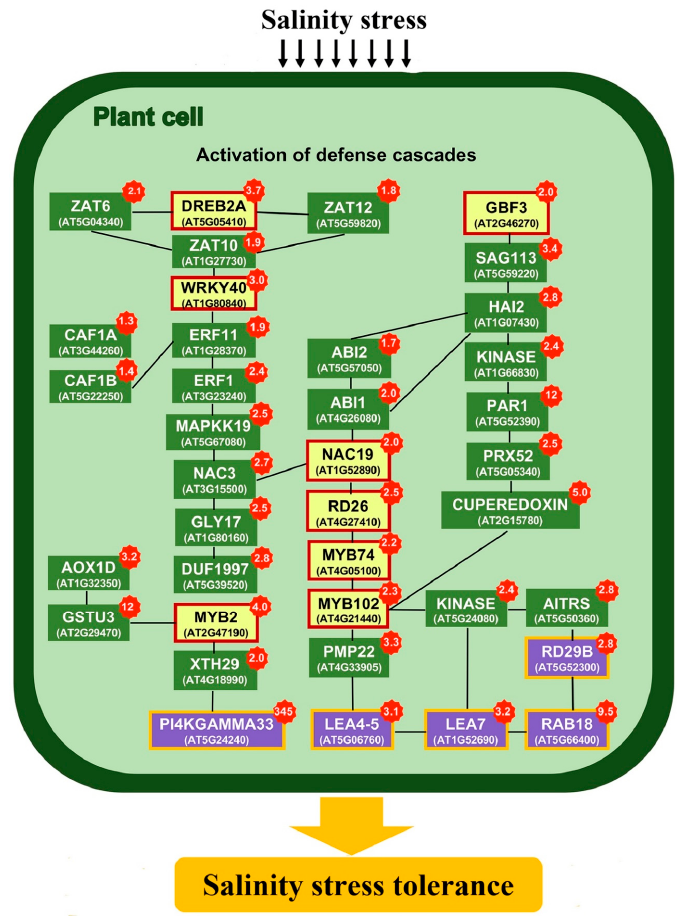
Figure 5. Co-expression analysis of genes induced by salinity stress (GO:0042538). Listed in the yellow box are some of the main transcription factors that regulate the expression of several genes involved in salinity stress tolerance. In green boxes are listed genes involved in the activation of various defense mechanisms. In purple boxes are listed well characterized genes that are up-regulated in salinity and temperature stress in pairwise comparison of Es MS vs. WTS. Accession number for these genes and fold increase in expression for both time points are also listed in Supplementary Dataset S3. Values highlighted in red are the fold change of genes, in pairwise comparison of Es MS vs.